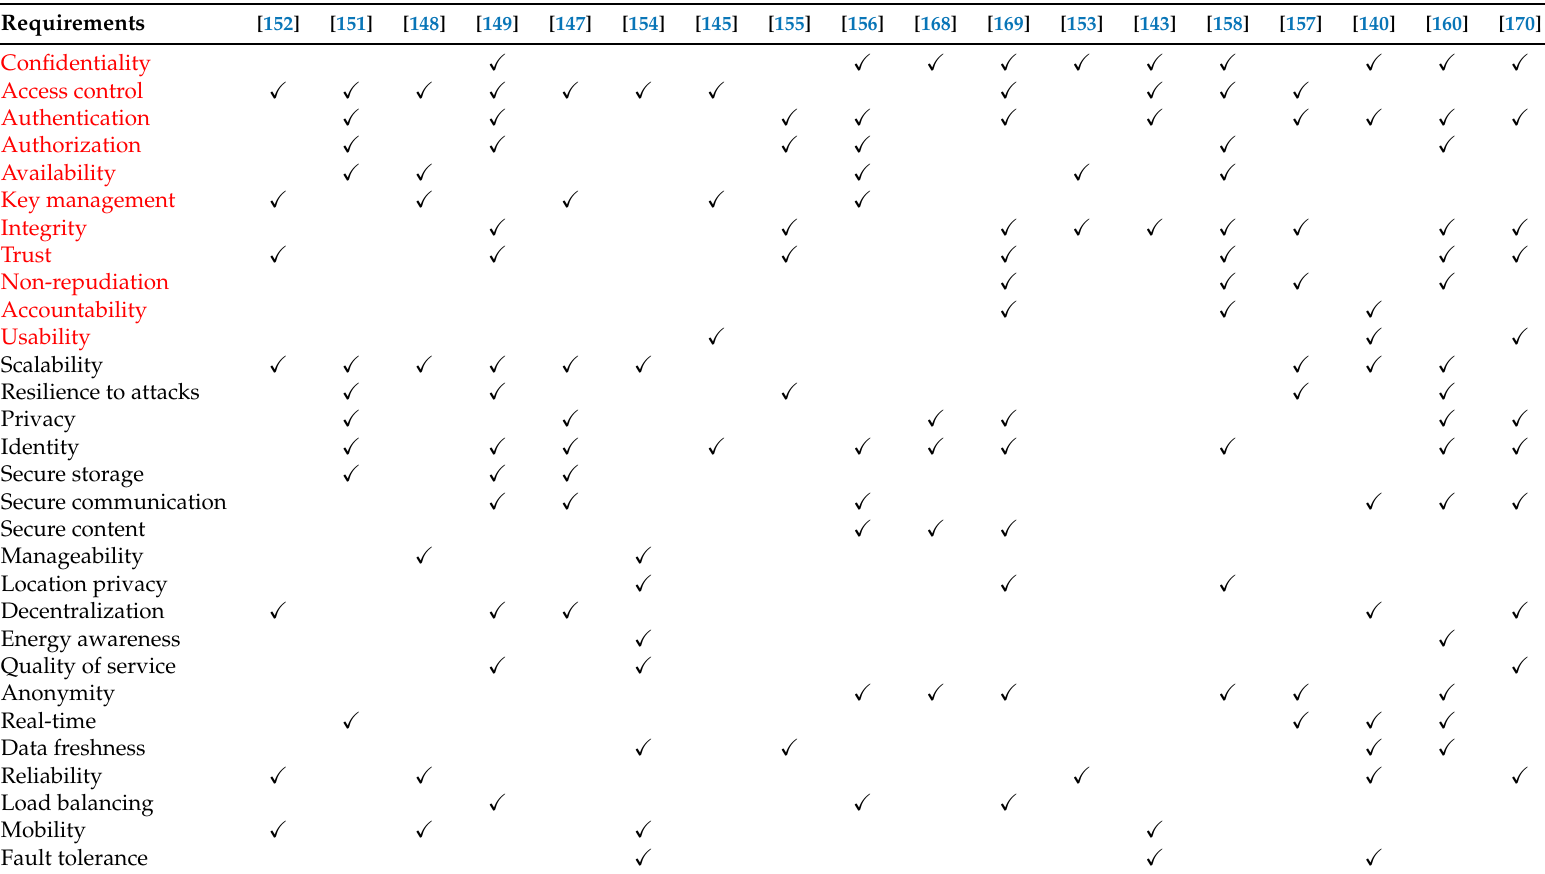
Table 4. Potential security requirements for the IoT identified in the existing literature. Red colour represents ‘standard’ security requirements.